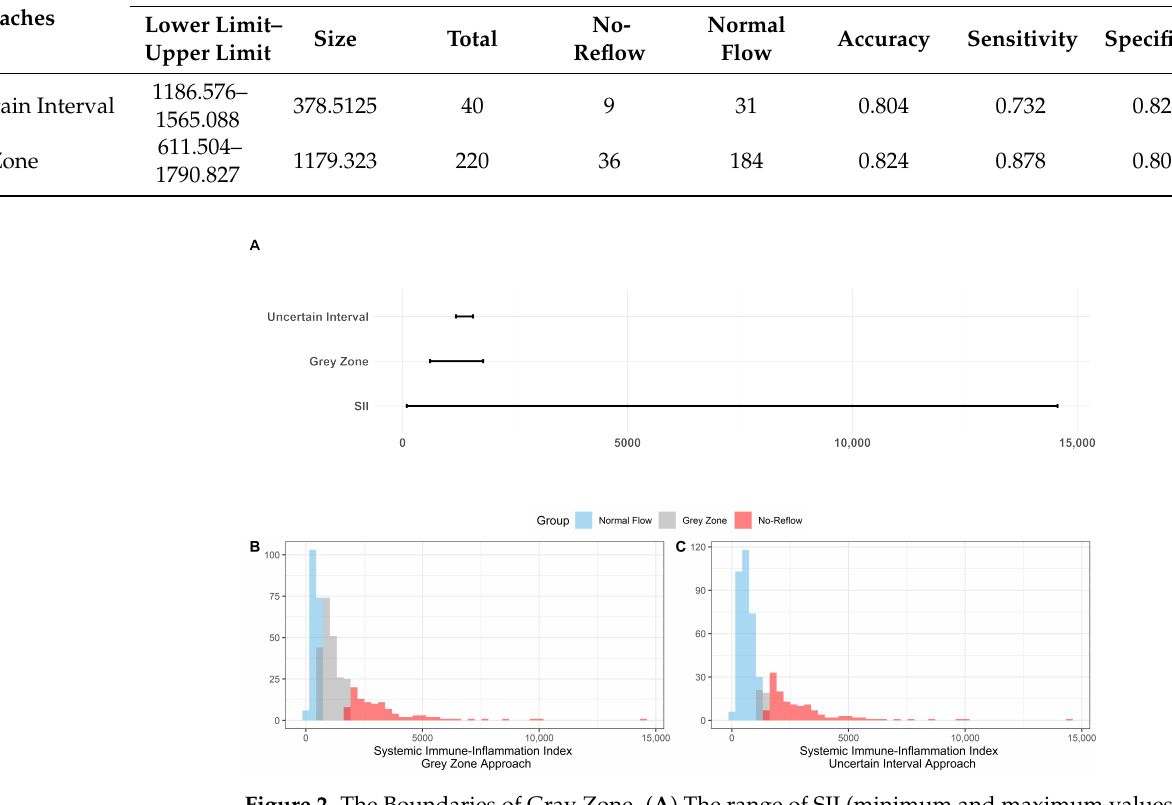
Figure 2. The Boundaries of Gray Zone. ( A ) The range of SII (minimum and maximum values were recorded as 92.2 and 14562.2) is given in the bottom line while the boundaries of the gray zone are represented in the middle and the top lines with respect to the grey zone and the uncertain interval approaches. ( B ) Histogram of SII with the representation of the 3 classes based on the grey zone approach as the normal flow, gray zone, and no-reflow. ( C ) Histogram of SII with the representation of the 3 classes based on the uncertain interval approach as the normal flow, gray zone, and no-reflow. It can clearly be seen that the grey zone approach had wider limits of the gray zone boundaries compared to the uncertain interval approach. Moreover, as is expected due to the size of the gray zone, the number of patients who are in the gray zone is lower in the uncertain interval approach compared to the grey zone approach. The accuracy and sensitivity of the grey zone approach were higher than the uncertain interval approach, while its specificity was lower compared to the uncertain interval approach. There was no statistical difference in accuracy (0.804 versus 0.824, p = 0.127) and specificity (0.824 versus 0.806, p = 0.188) between the uncertain interval and grey zone approaches, respectively. The statistical difference was significant for sensitivity (0.732 versus 0.878, p <